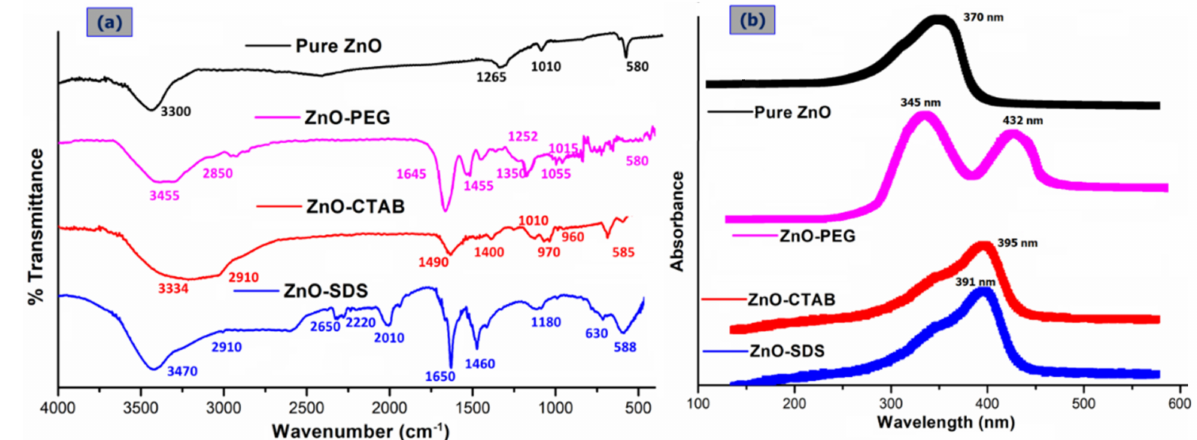
Figure 1. Comparison of the FTIR ( a ) and UV–vis ( b ) spectra of pure ZnO with that of surfactant- coated ZnO NPs (ZnO–PEG, ZnO–CTAB, and